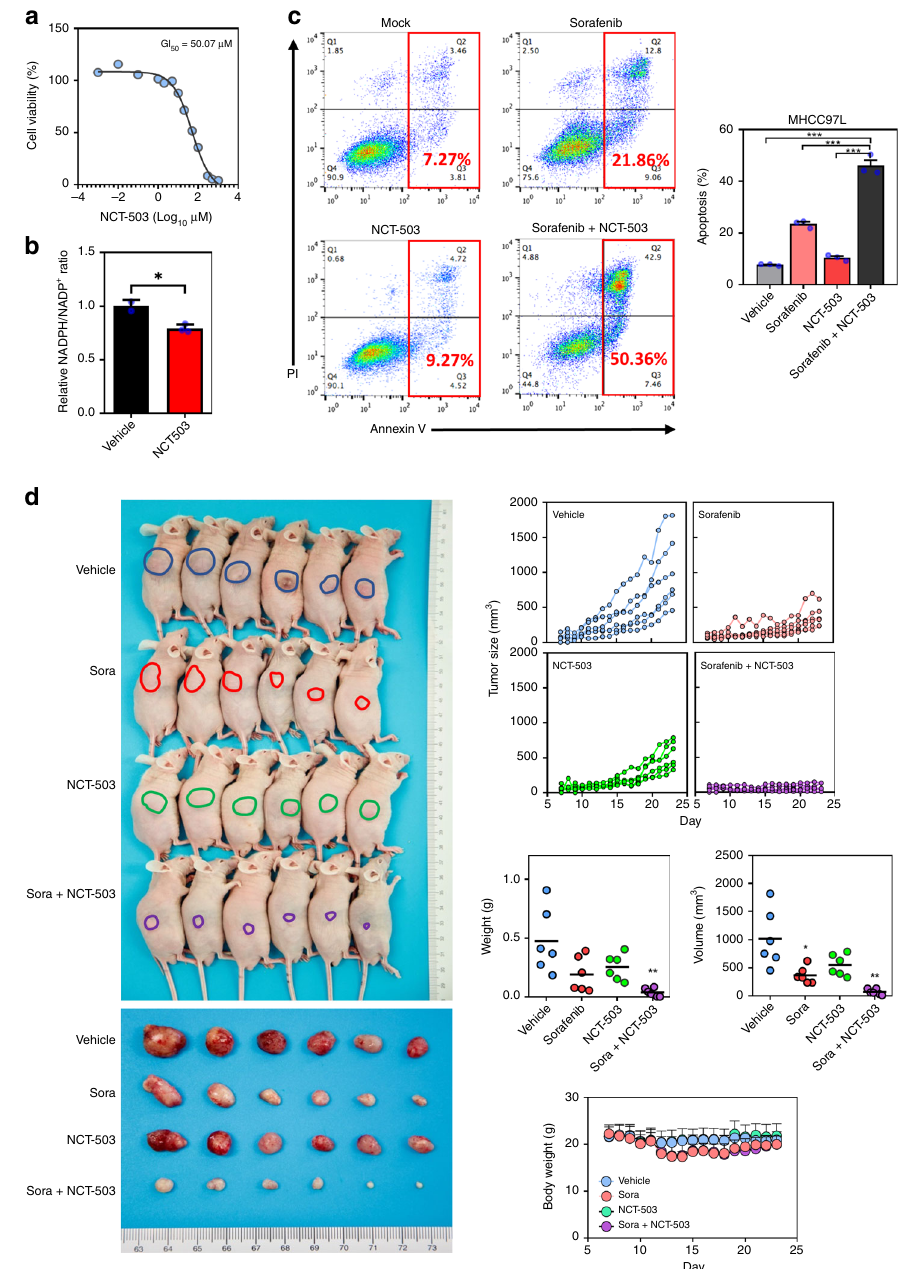
Fig. 5 PHGDH inhibitor sensitized HCC cells to Sorafenib treatment. a NCT-503 inhibited HCC cell proliferation in a dose-dependent manner with 50% growth inhibiting (GI50) at 50 µ M. b Treatment of NCT-503 at 40 μ M for 48 h signi fi cantly reduced the relative ratio of NAPDH/NAD + in HCC cells. c Annexin V-PI staining showed that NCT-503 worked synergistically with Sorafenib to induce HCC cell apoptosis. d Both NCT-503 and Sorafenib inhibited HCC tumorigenicity. NCT-503 and Sorafenib combination therapy effectively abolished HCC growth in the nude mice model (blue connected dots: vehicle- treated group; red connected dots: Sorafenib-treated group; green connected dots: NCT-503-treated group; purple connected dots: Sorafenib and NCT- 503-treated group). The error bar in panels b and c represents the SEM, n = 3 biological independent samples. The error bar in panel d represents the SD, n = 6 mice. Source data are provided as a Source Data fi le (Student's t -test * P < 0.05, ** P < 0.01, *** P <